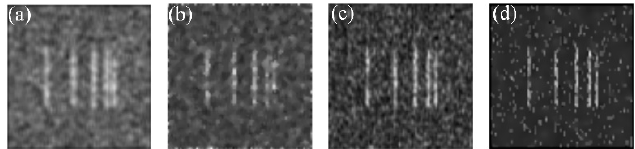
Figure 8. Experimental results for the imaging object “Slits” obtained by the mean filter -IPGI, median filter -IPGI, Gaussian filter -IPGI and AD-IPGI with 2000 measurements: ( a ) mean filter -IPGI, ( b ) median filter -IPGI, ( c ) Gaussian filter -IPGI, and ( d ) AD-IPGI.